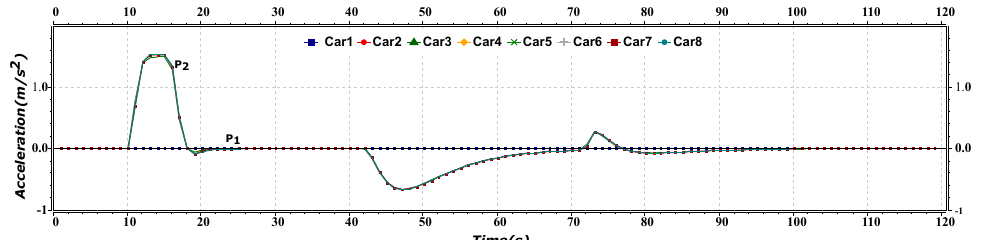
Figure 5. Distance versus time graph of merge maneuver. Figure 6 represents the acceleration versus the time of the merge maneuver of the pla- toon. The P 1 (including Car1–Car4) line shows the acceleration of the front platoon, whereas the P 2 (including Car5–Car8) shows the acceleration of the rear platoon. Initially, both platoons are moving with the same acceleration. After approximately 12 s, as the rear platoon increases its speed, its acceleration changes from 0 to 1.5 m/s 2 . After nearly 43 s, acceleration starts reducing as the rear leader AV decreases its speed to match the speed of the front platoon AV.